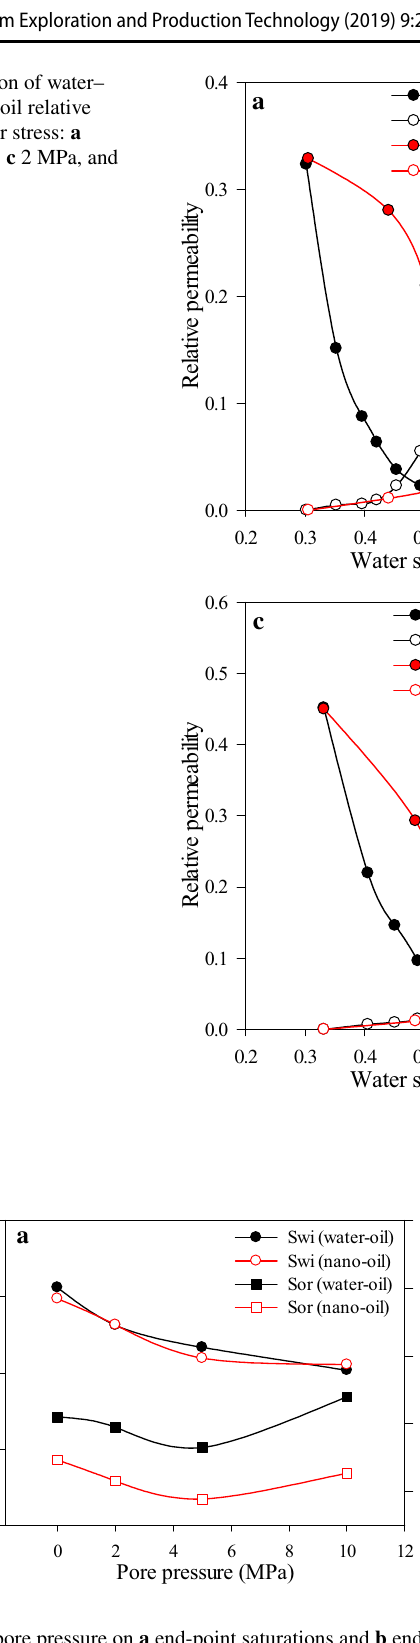
Fig. 12 Effect of pore pressure on a end-point saturations and b end-point relative